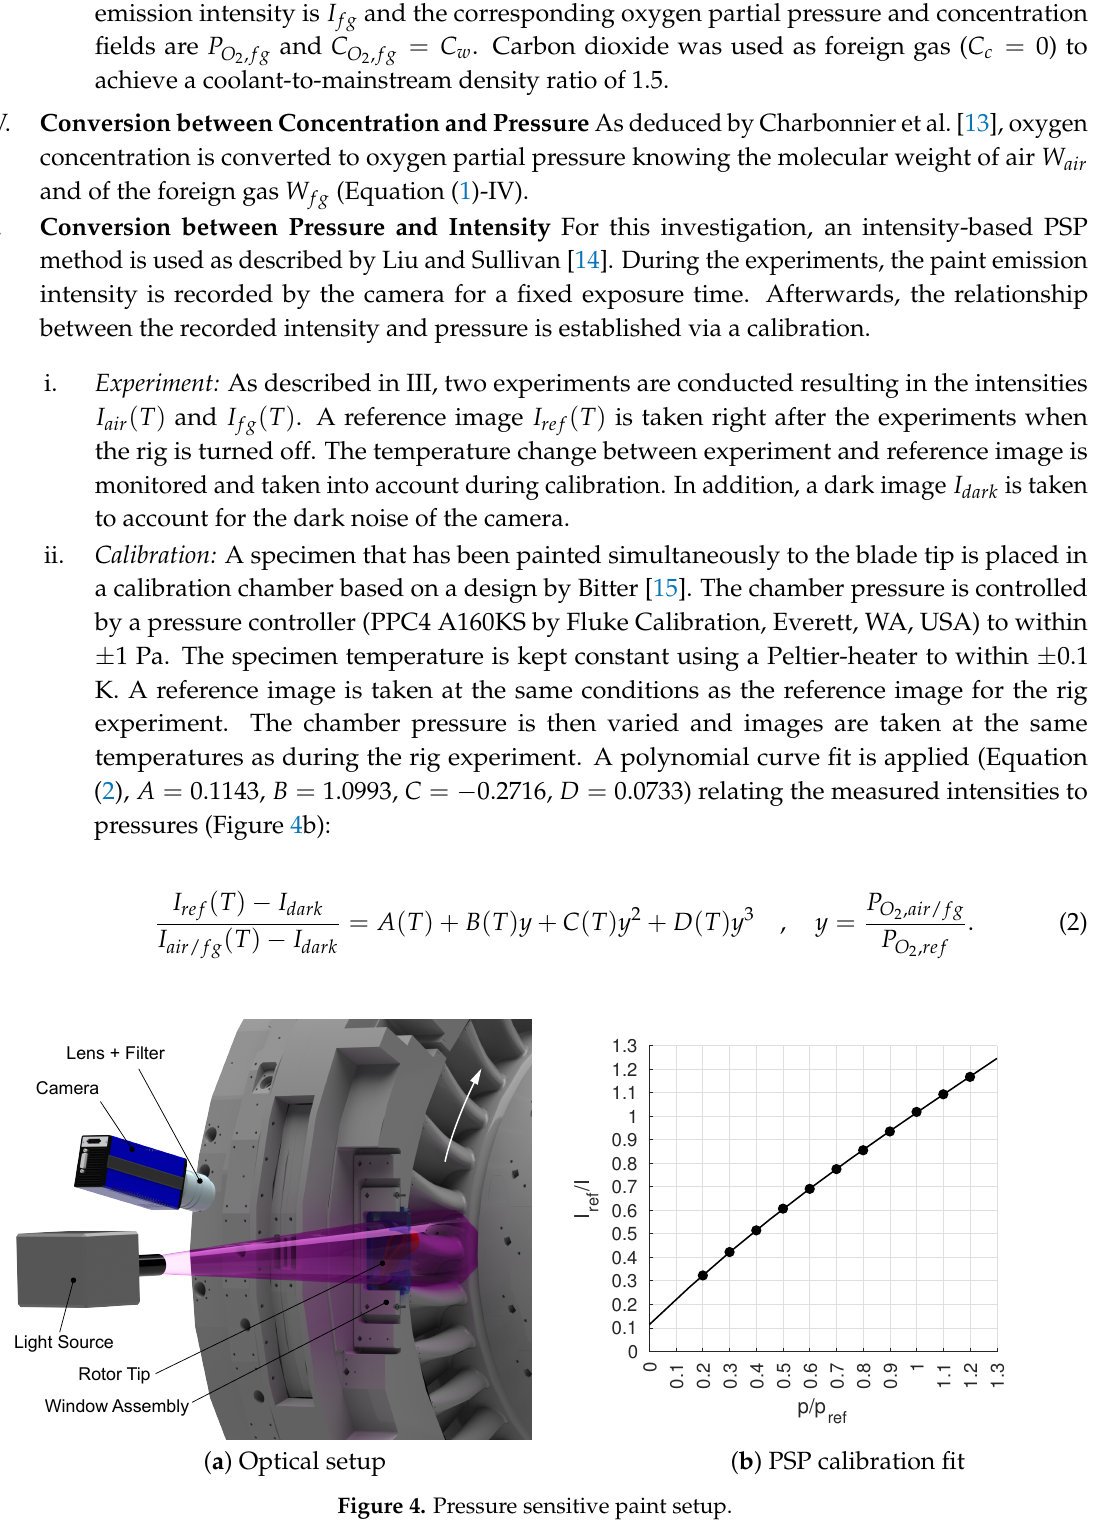
Figure 4. Pressure sensitive paint